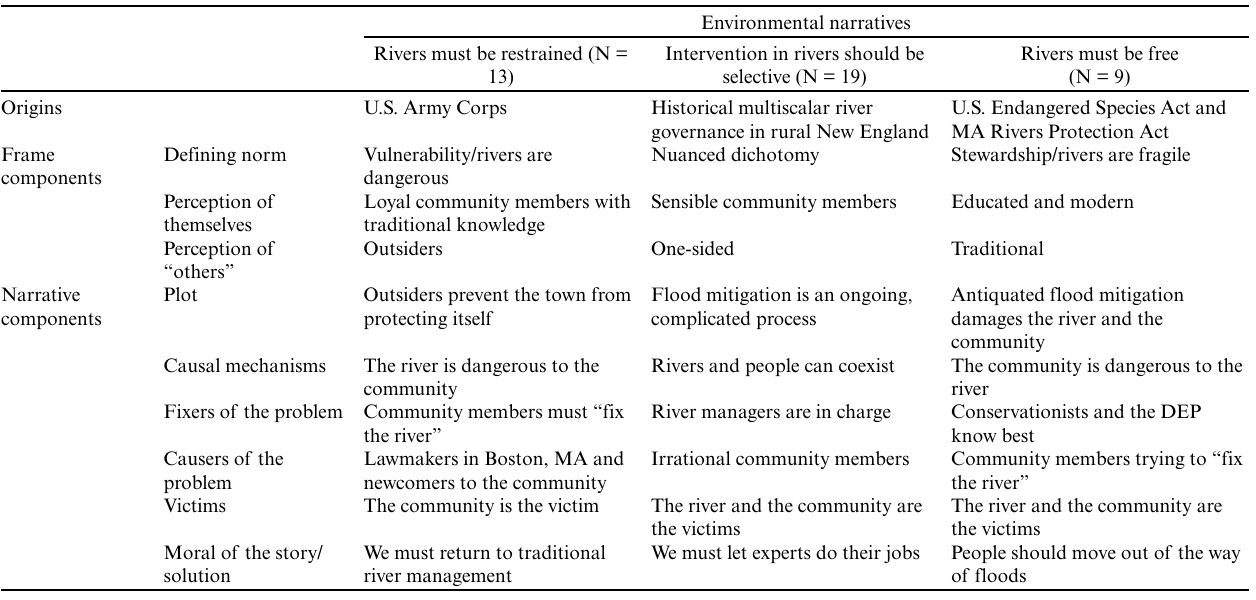
Table 1 . Summary and comparison of environmental narrative structures, based upon framework developed by Jones and McBeth (2010). MA, Massachusetts; DEP, Massachusetts Department of Environmental